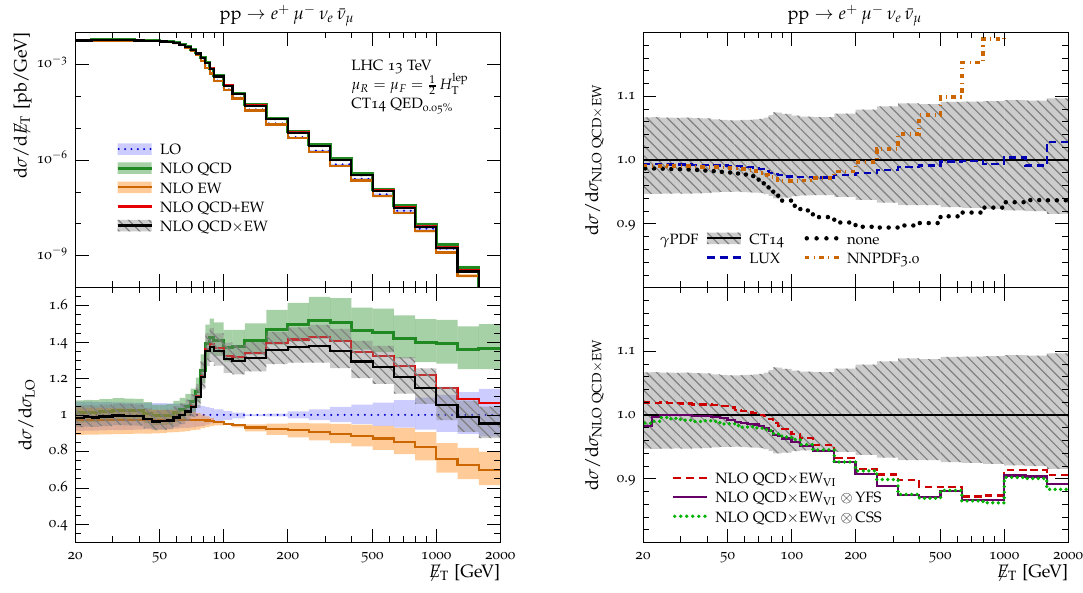
Figure 11 . Distribution of the missing transverse momentum, Details as in (cid:12)gure